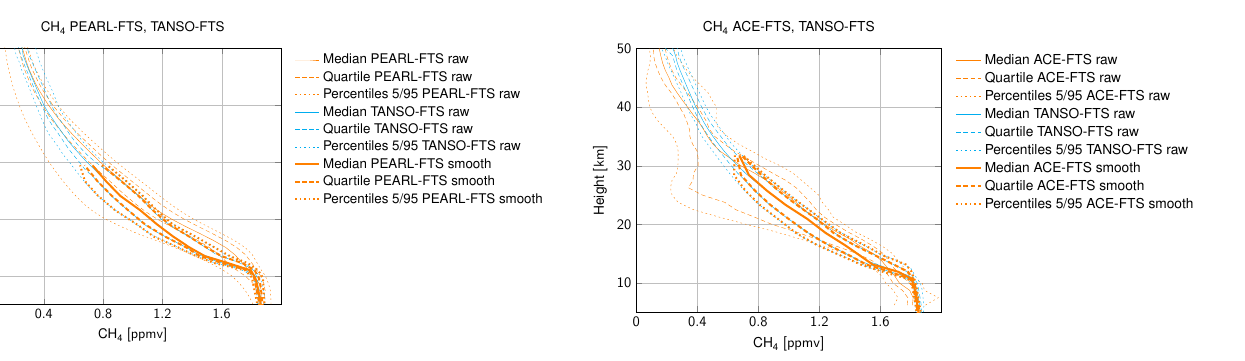
Figure 11. As in Fig. 9, but for PEARL-FTS and TANSO-FTS.